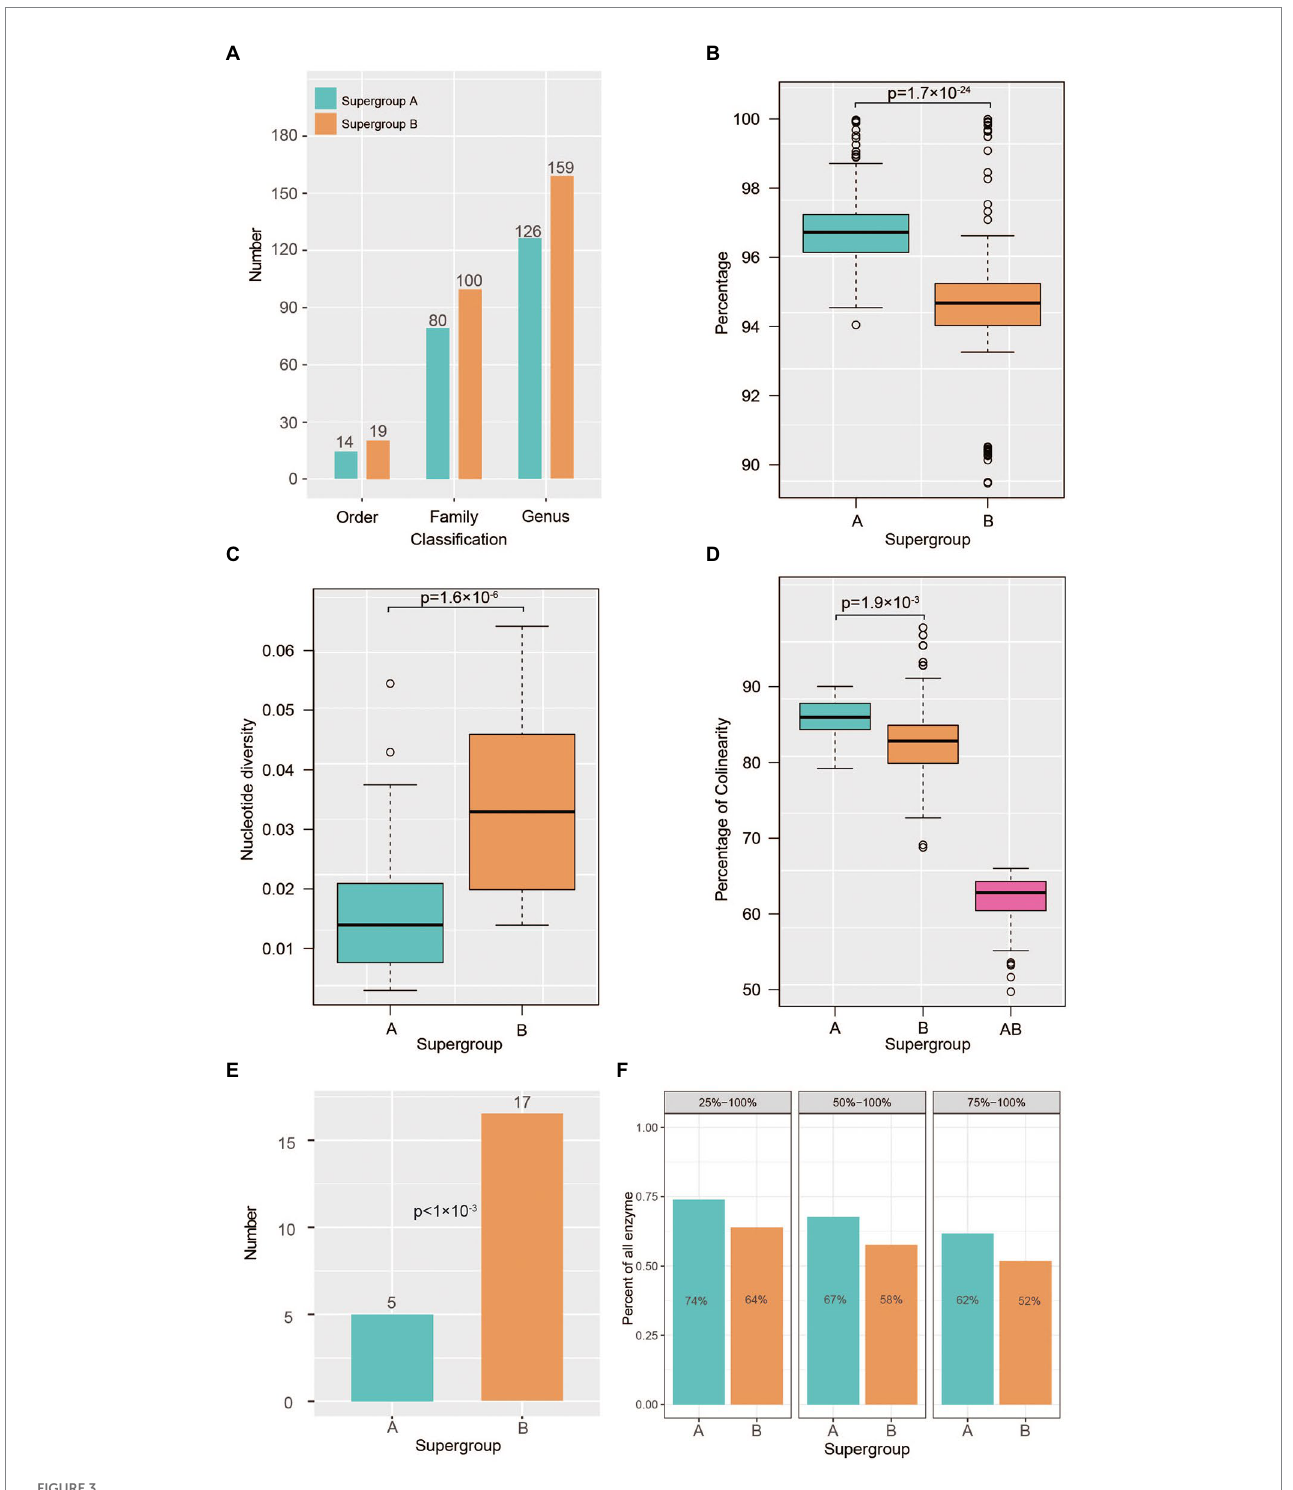
FIGURE 3 Rapid genomic evolution in Wolbachia supergroup B strains. (A) Statistics of host species numbers among supergroups A (green box) and B (orange box) based on studies in the last 20 years. (B) Analysis of whole-genome identity within supergroups A and B. (C) Nucleotide diversity (Pi) within supergroups A (green box) and B (orange box). (D) Percentage of syntenic genes of each pair of strains within supergroups A (green box) and B (orange box). And percentage of syntenic genes of each pair of strains between supergroups A and B (purple box) (E) Number of rapidly evolving gene families in the ancestors of supergroups A (green box) and B (orange box). Gene families with a p value <0.05 were defined as rapidly evolving families in the CAFÉ results. (F) Percentage of shared functional enzymes within supergroups A (green box) and B (orange box), where 25–100% indicates that more than 25% of Wolbachia strains in each supergroup shared the same functional enzyme; 50–100% indicates that more than 50% of Wolbachia strains in each supergroup shared the same functional enzyme; and 75–100% indicates that more than 75% of Wolbachia strains in each supergroup shared the same functional